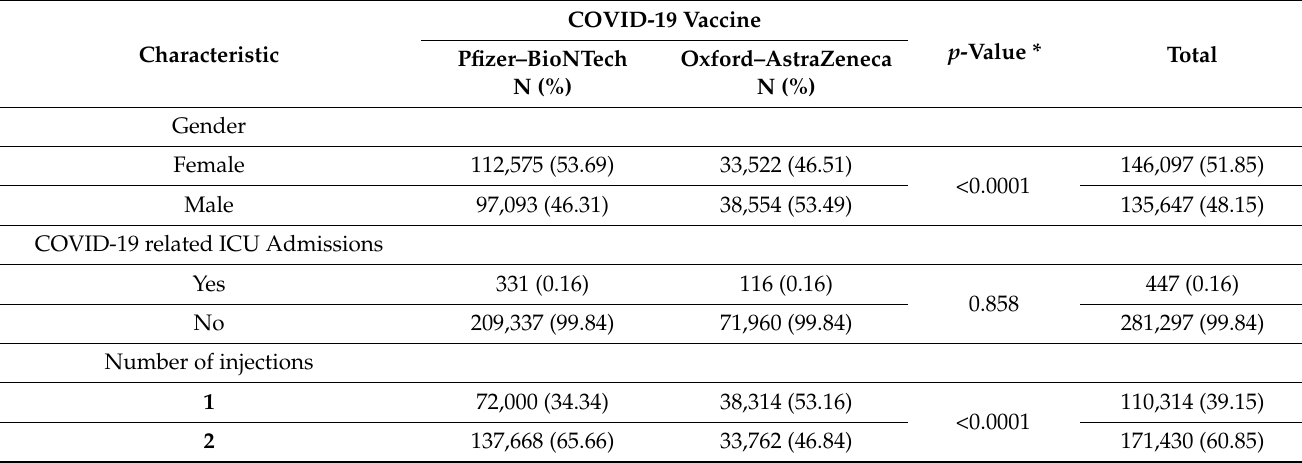
Figure 2. Number of persons vaccinated in each region.